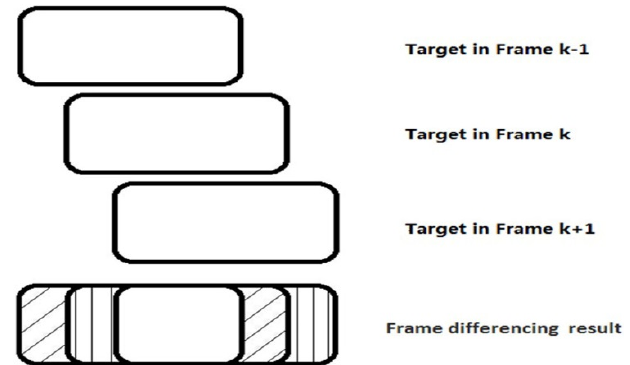
Figure 2. “Slow-moving” target in three consecutive frames. In frame differencing result, the diagonal-filled region is obtained by differencing between f k and f k-1 ; the vertical line-filled region is obtained by differencing between f k and f k+1 .